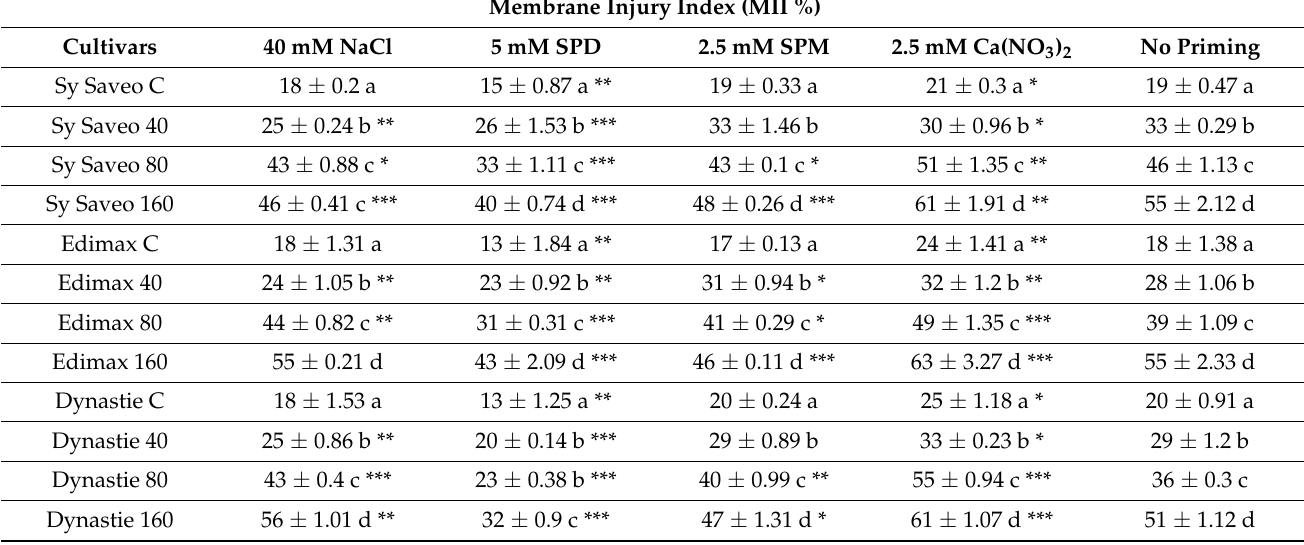
Table 4. Effect of different priming agents on membrane injury index (%) of rapeseed cultivars exposed to different saline ( n = 8). Mean values in the column marked by different letters are significantly different within the same group ( p ≤ 0.05; ANOVA and Tukey–Kramer test). Significant differences between groups are reported as * p < 0.05; ** p < 0.01; *** p <